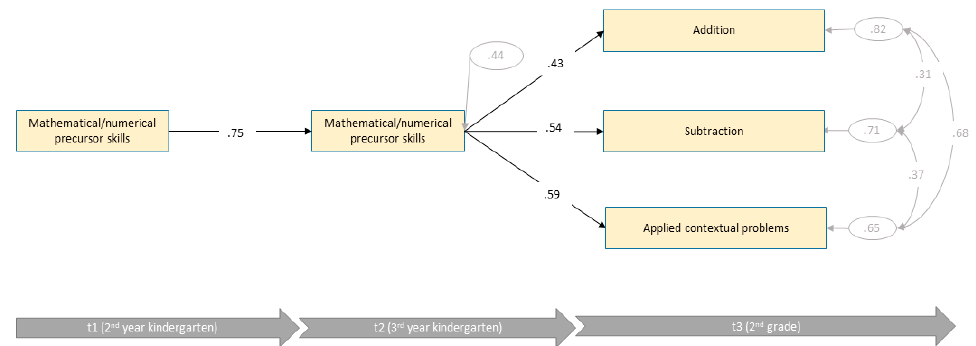
Figure 3. Final path model of the low intellectual ability group with standardized path coefficients ( n = 131).